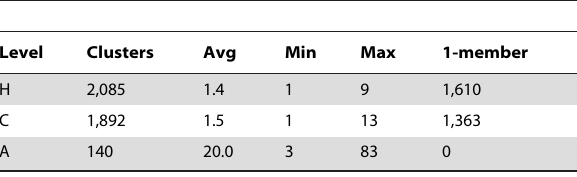
Table 7. A three-level hierarchy obtained using the new feature-based interface similarity